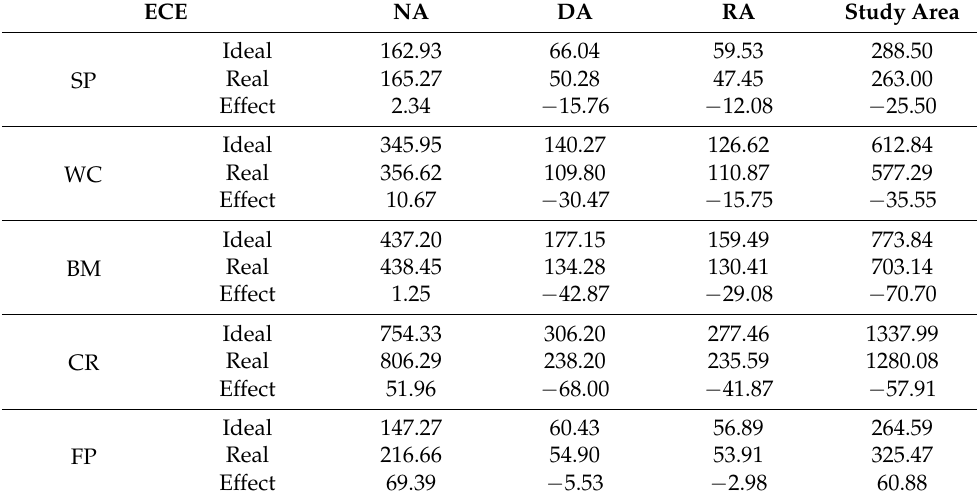
Table 4. ECE of different ecological service functions in NA, DA, and RA (million